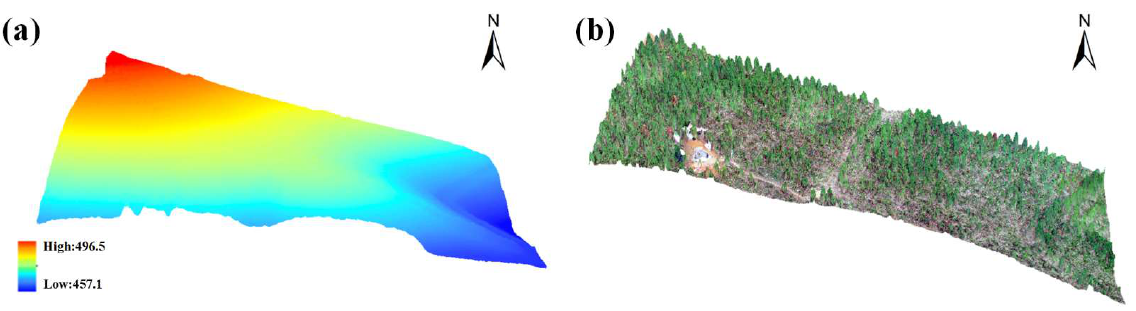
Figure 3. DEM derived from UAV images ( a ) and 3D visualization of UAV image in 2021 overlayed DEM ( b ) in the study area.